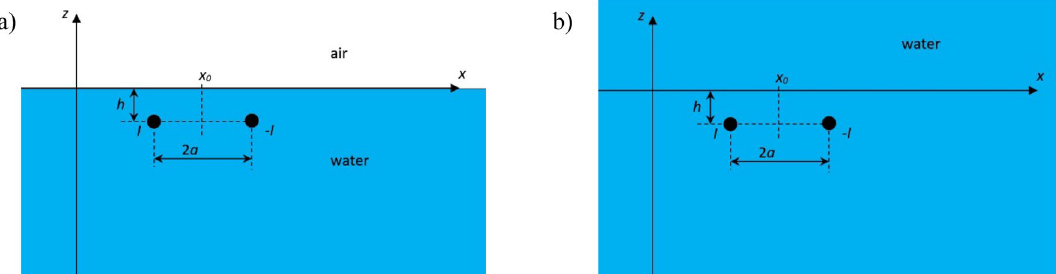
Figure 2. Electric electrodes in seawater: ( a ) two layers: air and water; ( b ) one layer: